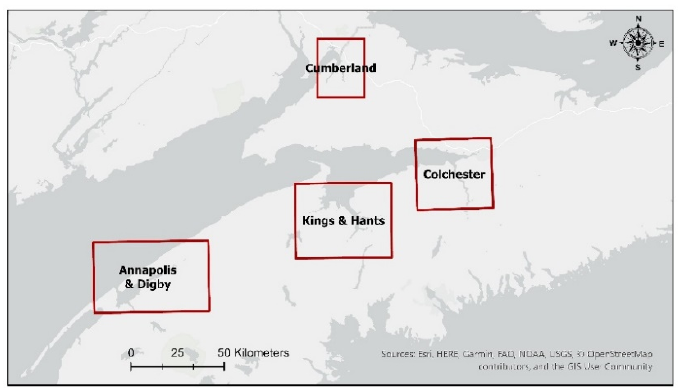
Figure 1. Geographical distribution of analysis regions based on the provincial distribution of dykelands (adapted from van Proosdij et al. [14]).